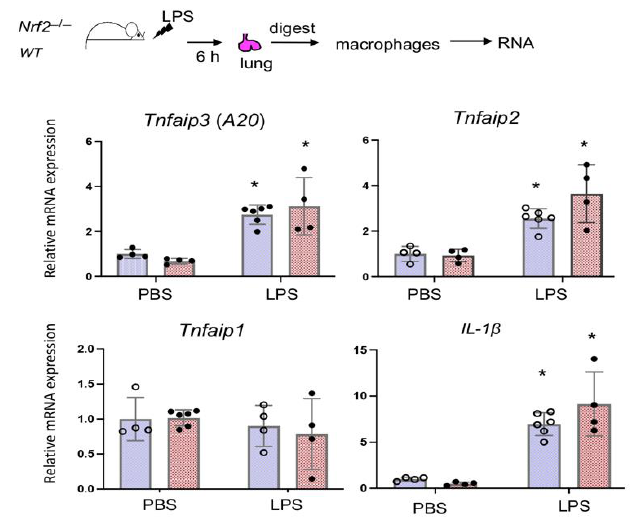
Figure 5. Nrf2 does not regulate A20 induction by LPS in LDMΦs in vivo. WT and Nrf2 – / – mice (males) were treated oropharyngeally with LPS (10 µg/mouse) for 6 h, and immediately sacrificed, lungs were perfused, harvested separately from 2-3 mice and lung digest from each mouse was plated on two different culture (60 mm) dishes, and attached macrophages were used for RNA isolation and cDNA preparation. A20 ( Tnfaip3 ), Tnfaip1 , Tnfaip2 and IL-1 β expression was analyzed by qRT-PCR. * versus PBS.